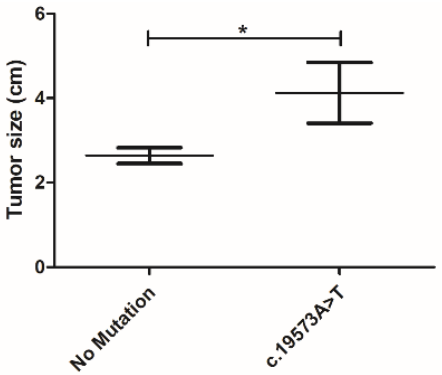
Figure 5. Mutations identified in feline her2 TK domain are not reported to induce therapeutic resistance in woman breast cancer. Most of the detected mutations were localized at intronic regions, although some of them were identified in exons, as a very frequent mutation in the exon 22 (c.20940 T > G; 85%; 34/40). Regarding the exon 20 that encodes for the protein region recognized by